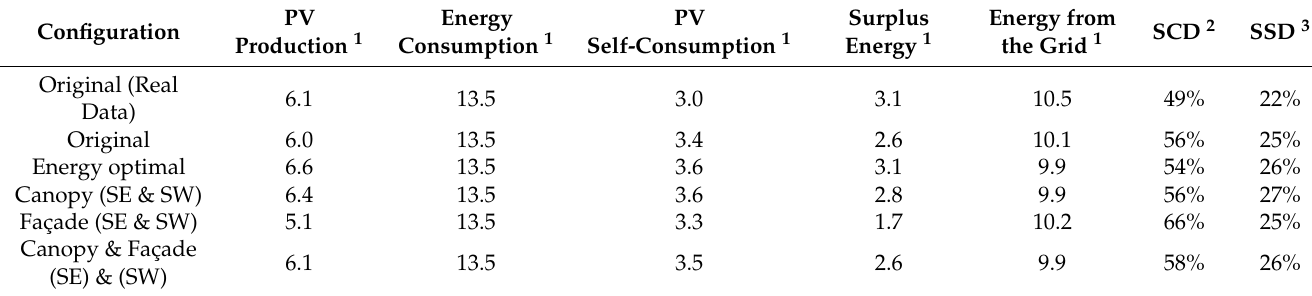
Table 4. Energy performance with the building and the grid of the different configurations for the PVSCS.